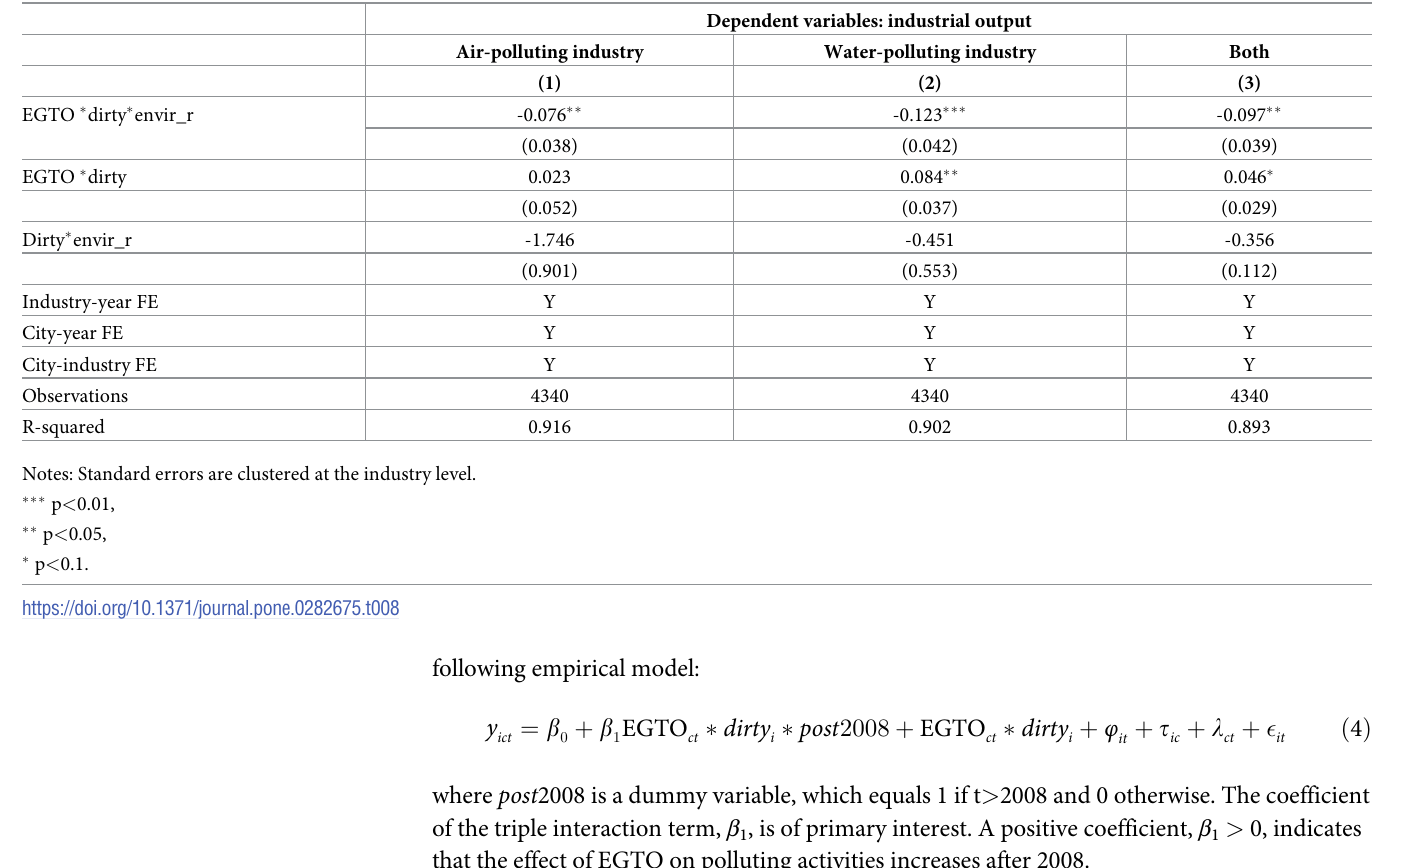
Table 8. Effect of EGTO with different intensity of environmental regulation.